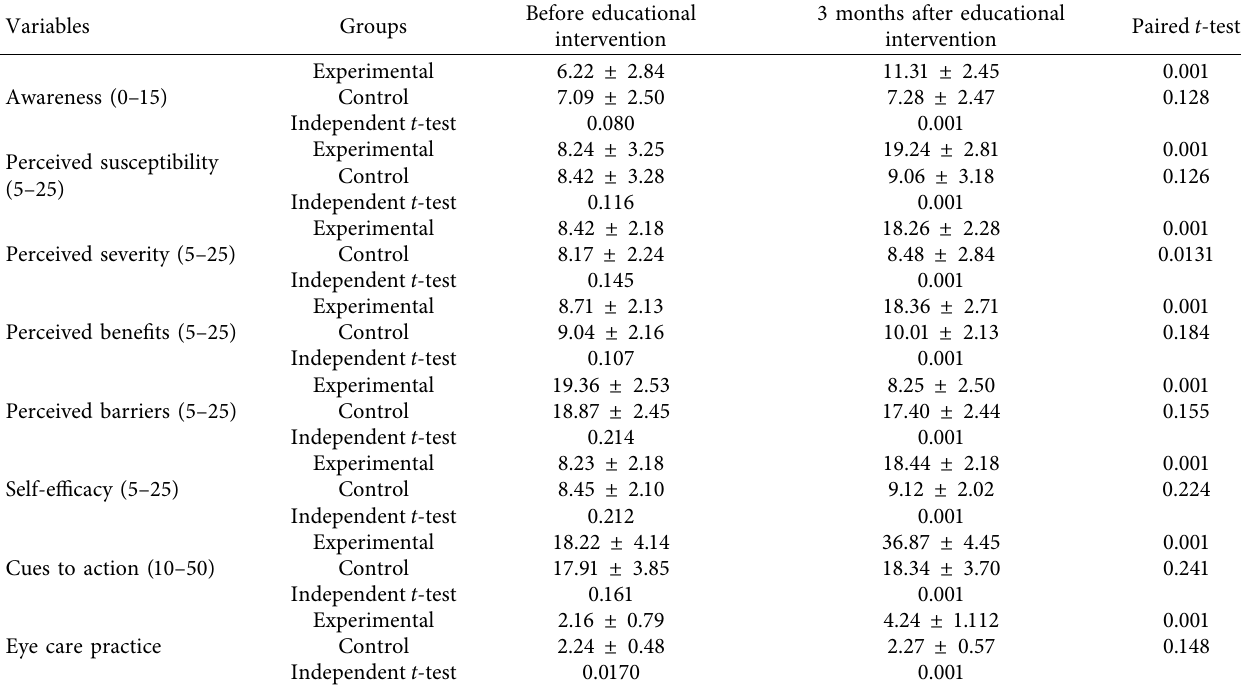
Table 2: Comparison of average scores of HBM components of studied subjects before and 3 months after the educational intervention in experimental and control groups.